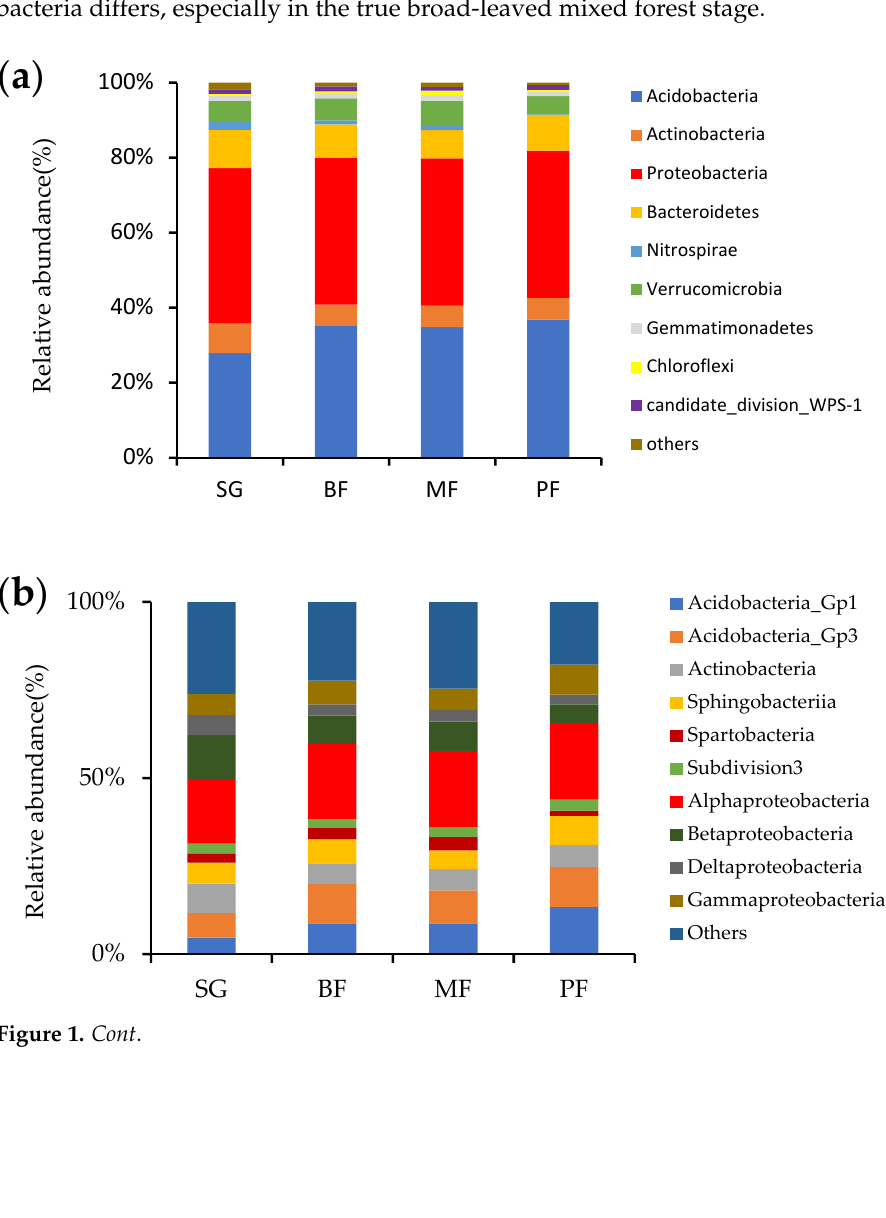
Figure 1. Distribution of bacterial communities in the different rehabilitation stages at different Phylum ( a ), Class ( b ), and Order ( c ) levels. SG: Shrub-grassland; BF: Broad-leaved; MF: Coniferous broad-leaved; PF: Primary forest. To further elucidate the degree of recovery of bacterial communities along the four successional stages, we compared the distances of the soils’ bacterial community between the PF, SG, BF, and MF stages. The averaged Bray–Curtis distance within PF was 0.36. The